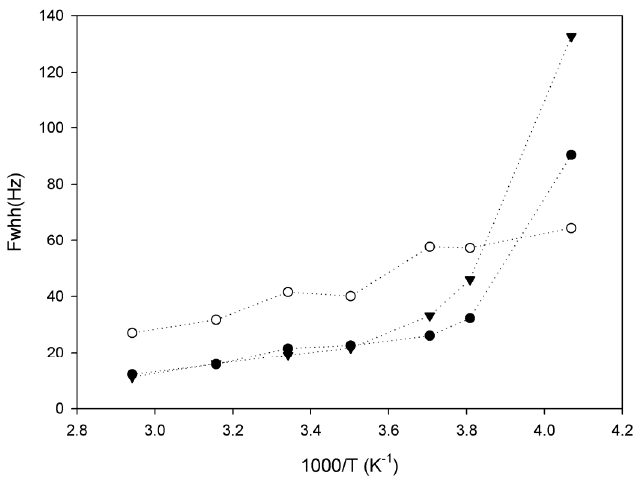
Figure 3. Evolution of 7 Li linewidth as a function of inverse temperature for sample 1 (black triangles), sample 2 (open circles) and sample 3 (black circles).